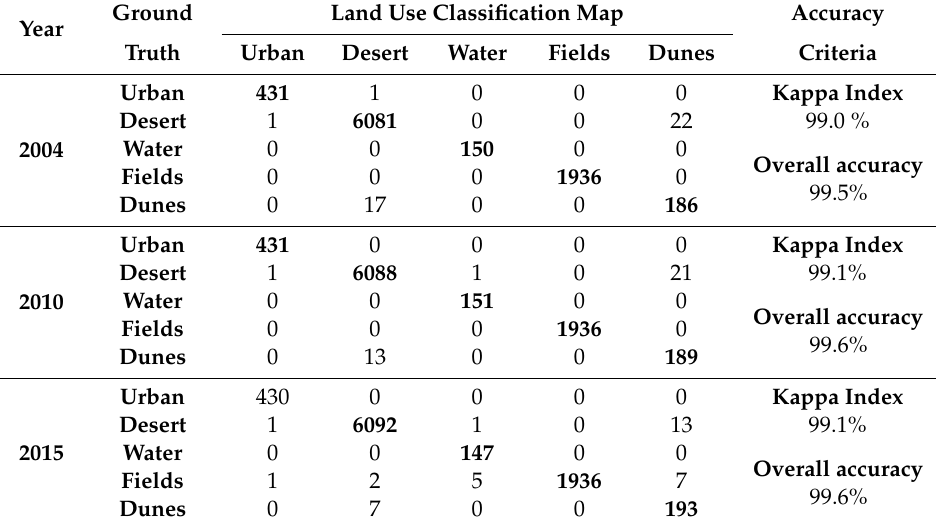
Table 4. Confusion matrix, Kappa index and overall accuracy of the resulting land use maps. Google Earth data are used as ground truth.